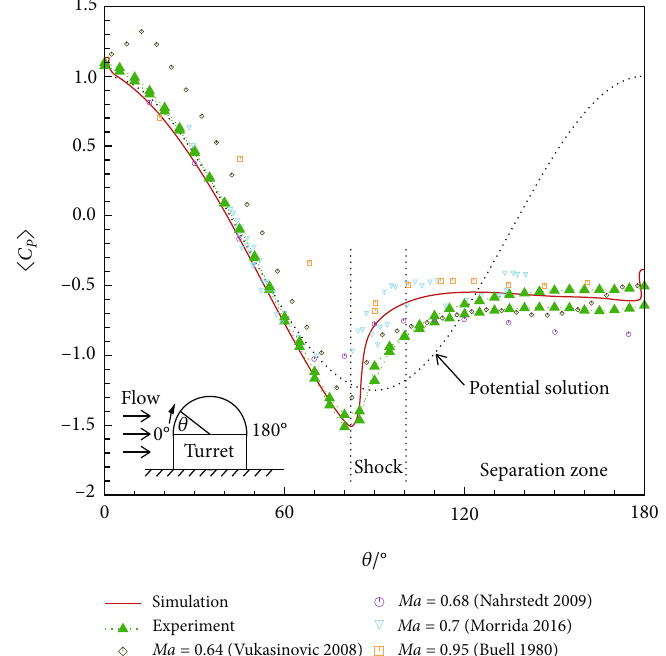
Figure 12: Time-averaged pressure coe ffi cient distribution along the turret centerline obtained by the simulation and two experiments, where the solid red line represents numerical simulation, the green triangles represent two experiments, and hollow shapes represent data [12, 13, 15,